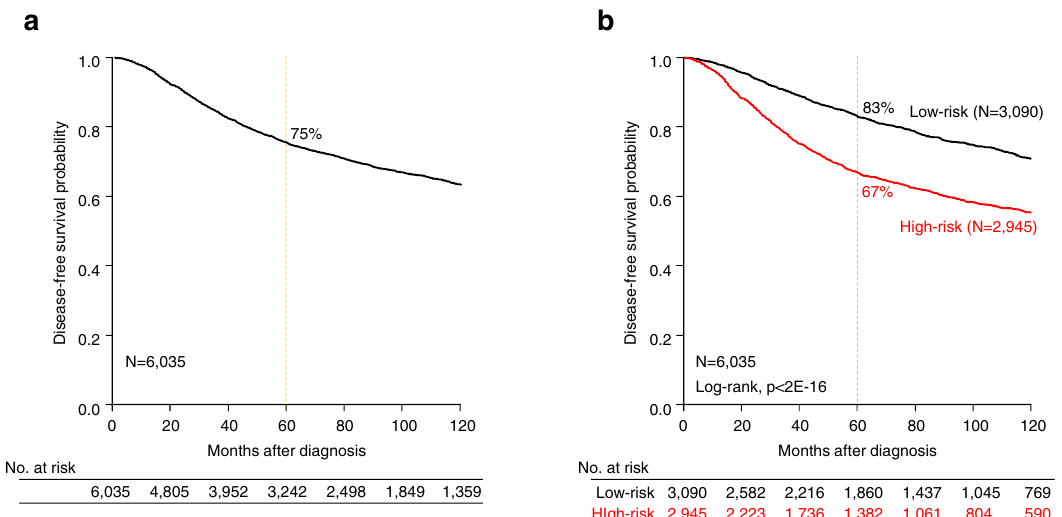
Fig. 1 Disease-free survival in early breast cancer patients. a Kaplan – Meier disease-free survival (DFS) curve in 6035 informative early breast cancer patients. b Similar to a , but according to the two CINSARC classes (high-risk vs. low-risk).